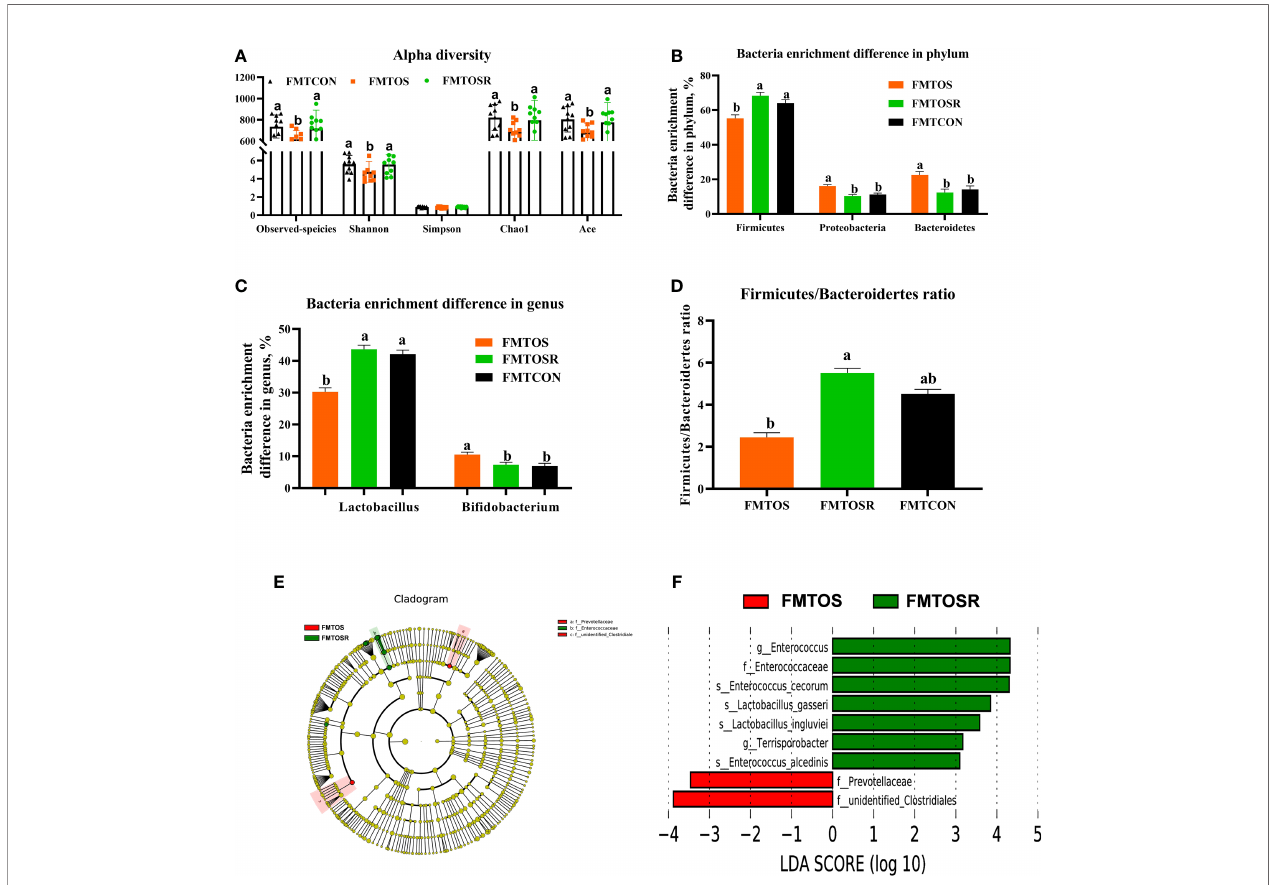
FIGURE 9 | Gut microbiota in response to microbiota transplantation from resveratrol supplementation diet (Exp.2). Data are means ± SEM represented by vertical bars or plot individual values ± SEM. (A) Alpha diversity, (B,C) Bacteria enrichment difference in phylum and genus, (D) Firmicutes/Bacteroidertes ratio, (E, F) Linear discrimination analysis coupled with effect size (LEfse) identi fi ed most differentially abundant taxa in the cecum with LDA signi fi cant threshold > 4 were shown. (Red) FMTCON enrichment taxa; (Green) FMTOS enrichment taxa; (Blue) FMTOSR enrichment taxa. CON = control, OS = oxidative stress (injection of 800 m mol/kg BW of tBHP), OSR = CON + 600 mg/kg resveratrol; FMTCON, FMTOS and FMTOSR indicated the microbiota-depleted layers were received microbiota transplantations from donor layer treated CON diet, tBHP and OSR, individually; Statistical signi fi cance was evaluated by the Turkey ’ s T-test, p <